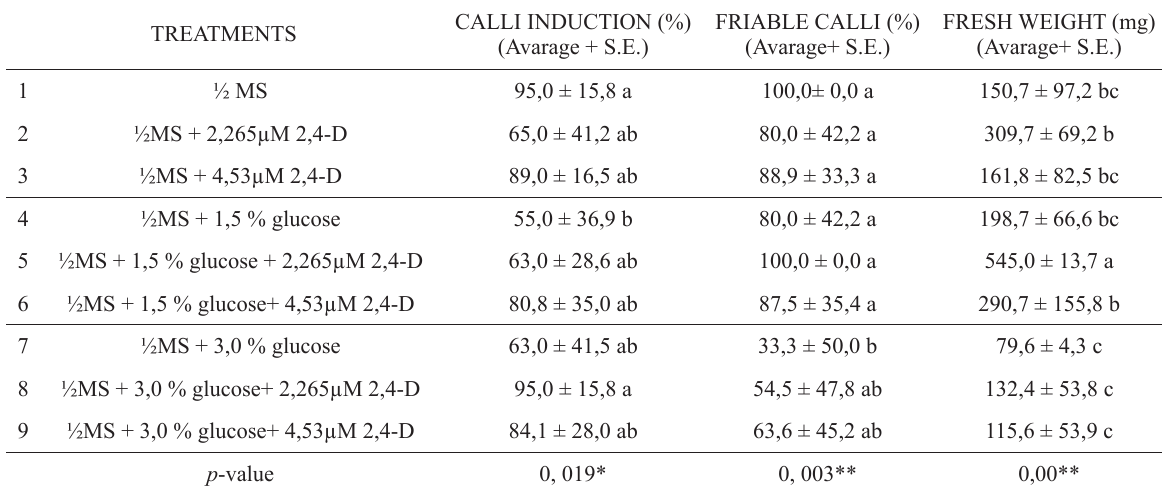
Callus induction of Boerhaavia paniculata Rich in ½ MS medium supplemented with 10%(v/v) coconut water and different concentrations of glucose and